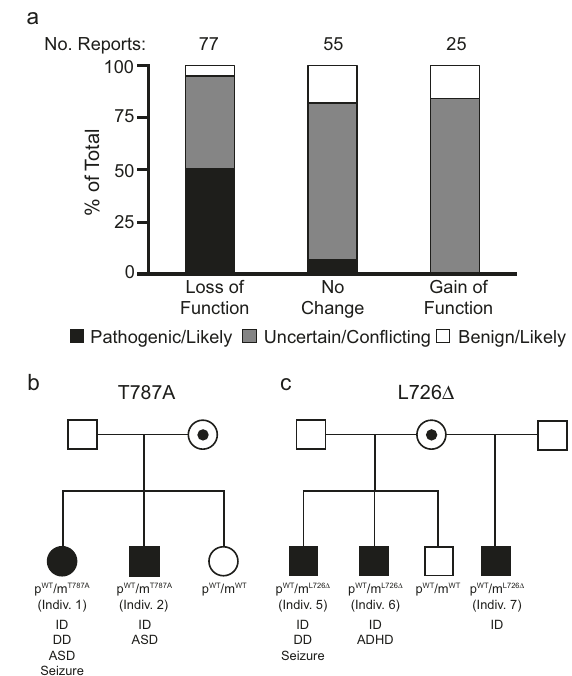
Fig. 7 UBE3A hyperactivity causes neurodevelopmental dysfunction. a Clinical interpretations in ClinVar for variants characterized in this study. The number of individual reports contained in ClinVar are shown for pathogenic/likely pathogenic (black), uncertain/con fl icting (gray), and benign/likely benign (white) variants. b , c Pedigree chart for the T787A ( b ) and L726 Δ ( c ) hyperactive mutations. ID intellectual disability, DD developmental delay, ASD autism spectrum disorder, ADHD attention- de fi cit/hyperactivity